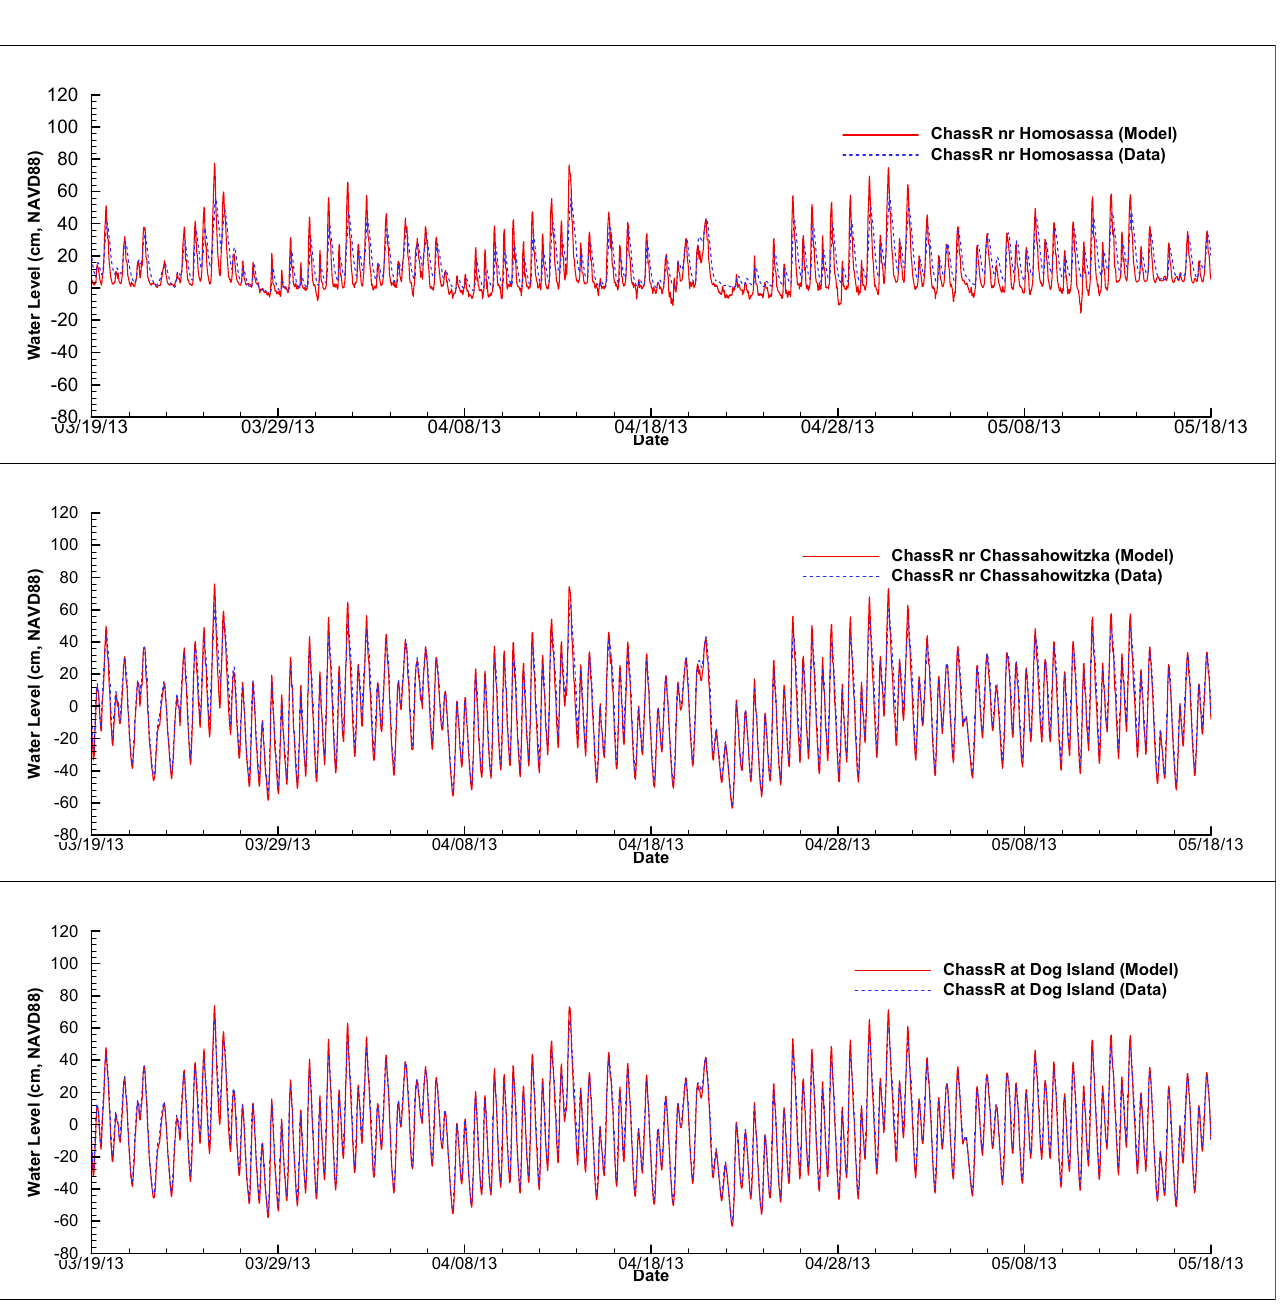
Figure 7. Comparison of measured and simulated water levels at the CRH ( top panel), CRC ( middle panel), and CRD ( bottom panel) stations from 19 March 2013 through 18 May 2013.